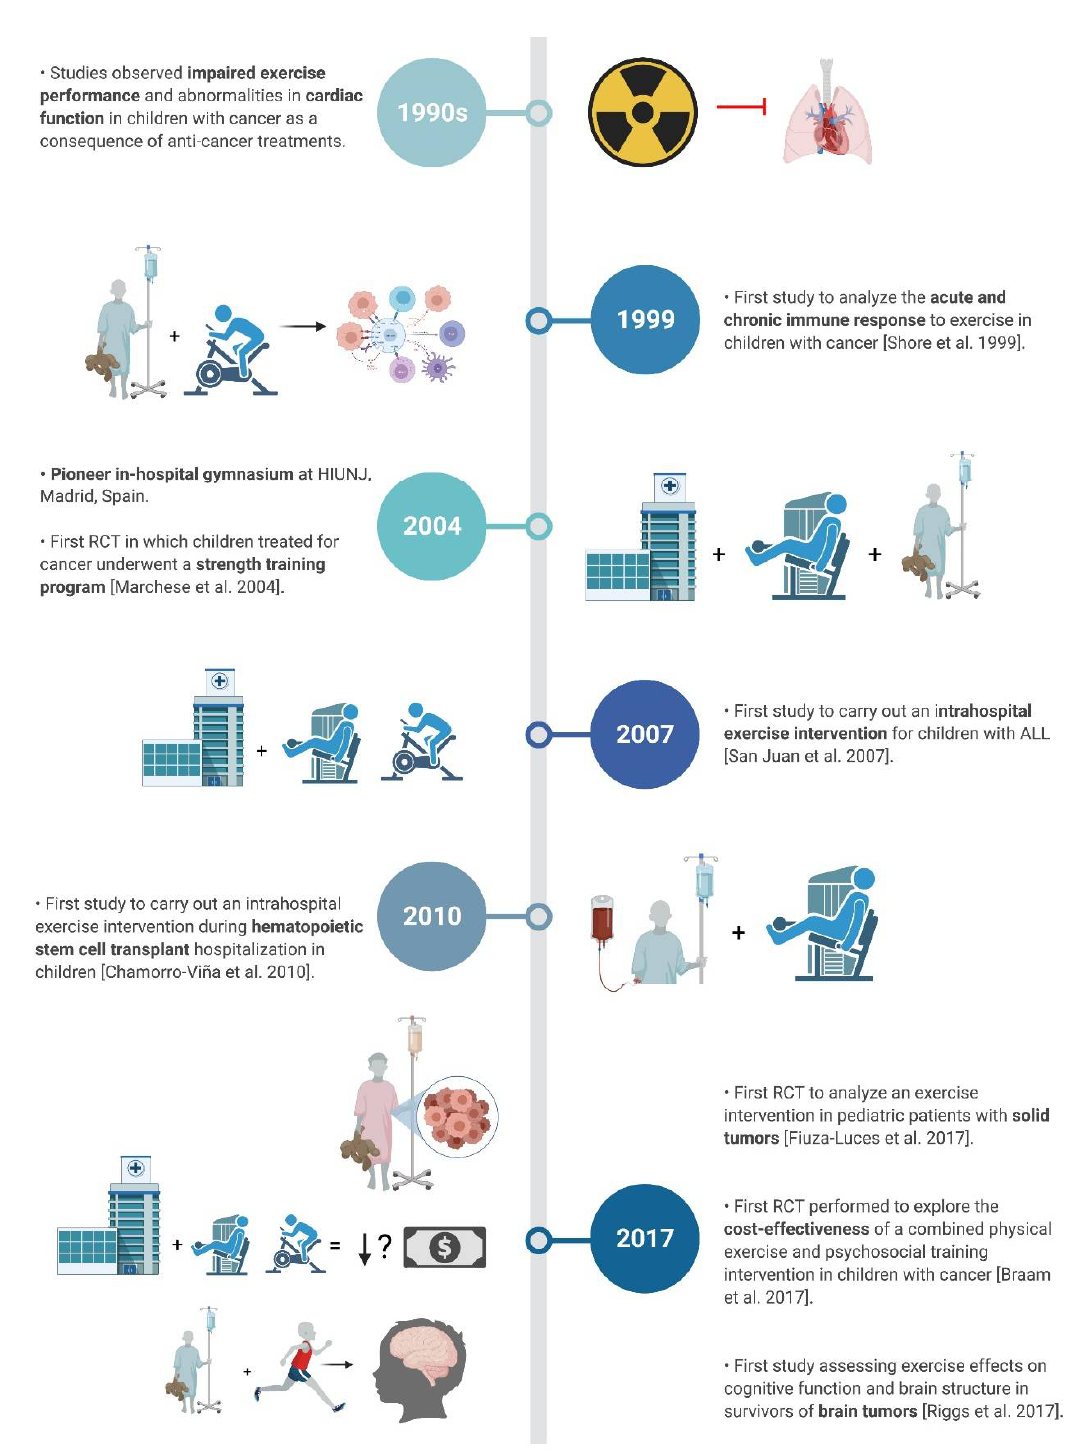
Figure 1. Distribution of articles according to the main milestones that contributed to knowledge on the childhood cancer on the childhood cancer and physical exercise binomial. Abbreviations: ALL, acute and physical exercise binomial. Abbreviations: ALL, acute lymphoblastic leukemia; HIUNJ, Hospital Infantil Universitario Niño Jesús; RCT, randomized controlled trial.